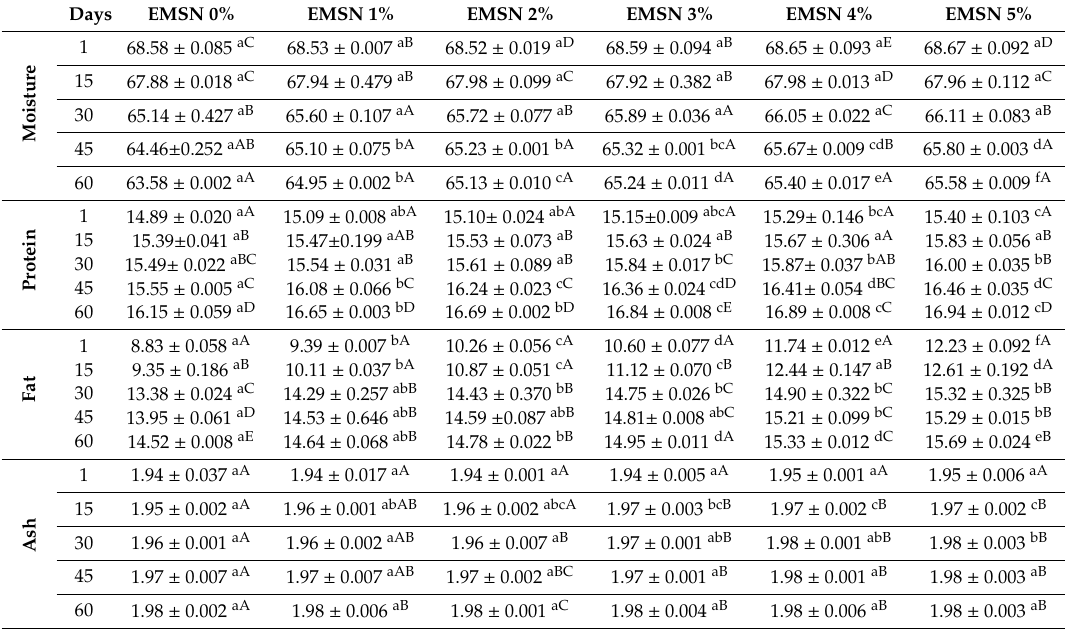
Table 2. Proximal composition of the emulsified meat system with nanoemulsion for the parameters of moisture, protein, fat and